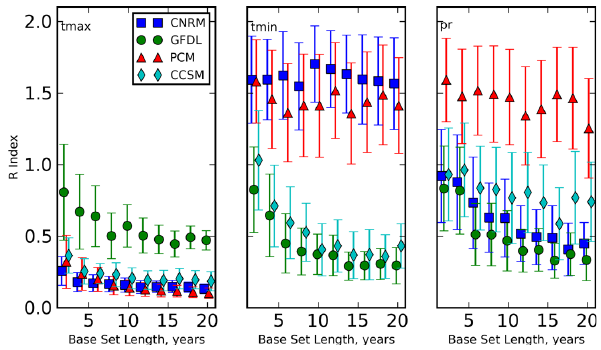
Fig. 10. Same as Fig. 9, but for cell